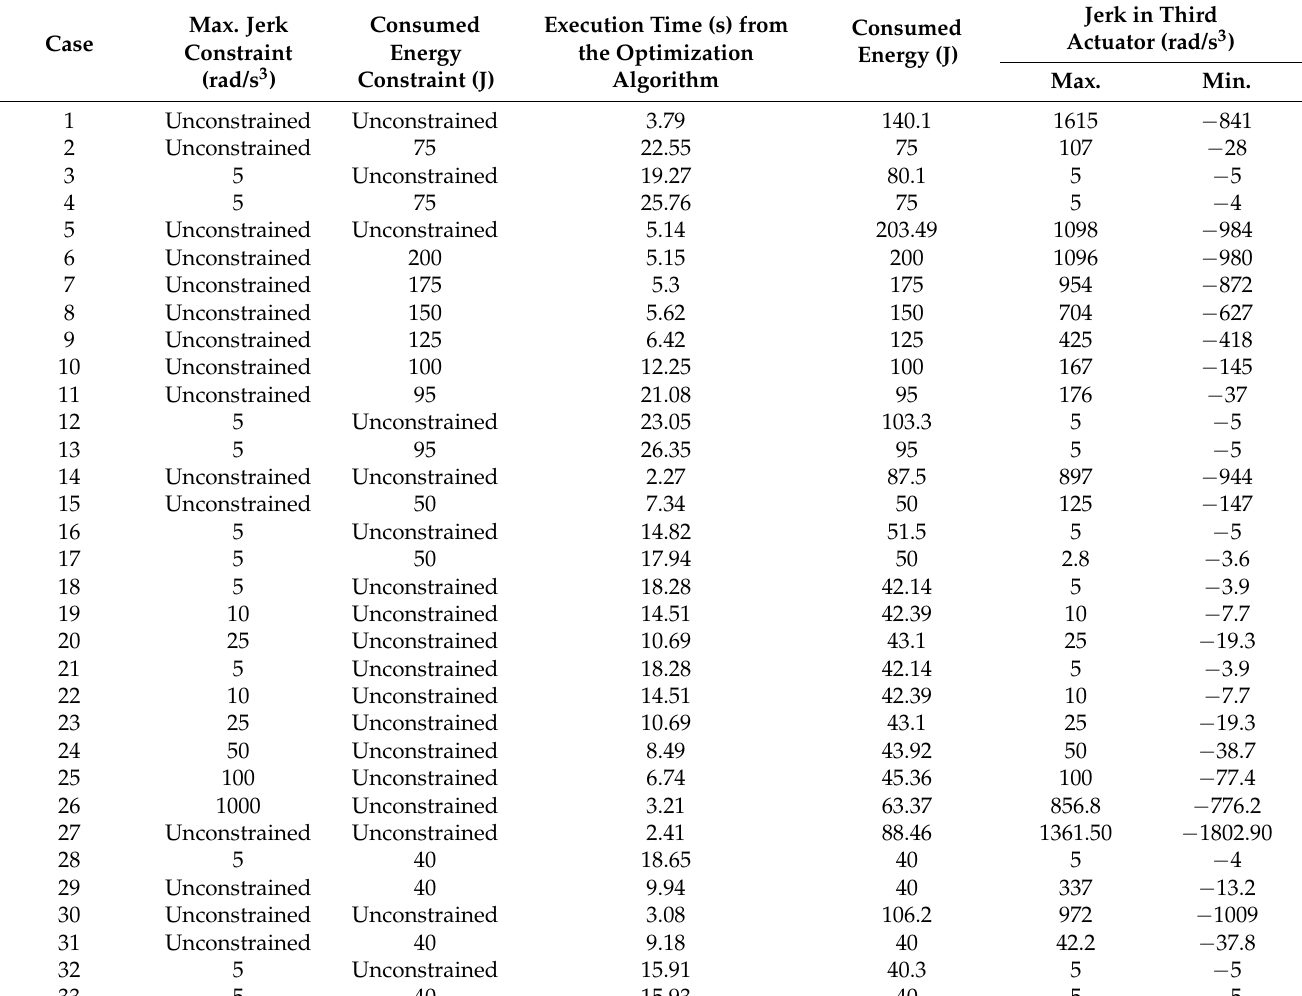
Table 2. Task execution time (s) obtained with the optimization algorithm for the set of cases. These times represent the desired motion and consider the physical restraints of the